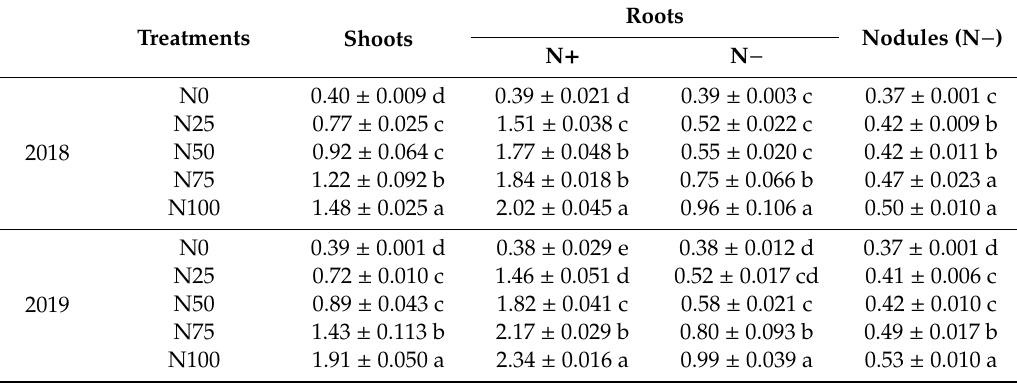
Table 4. 15 N abundance (%) in soybean with dual roots of experiment